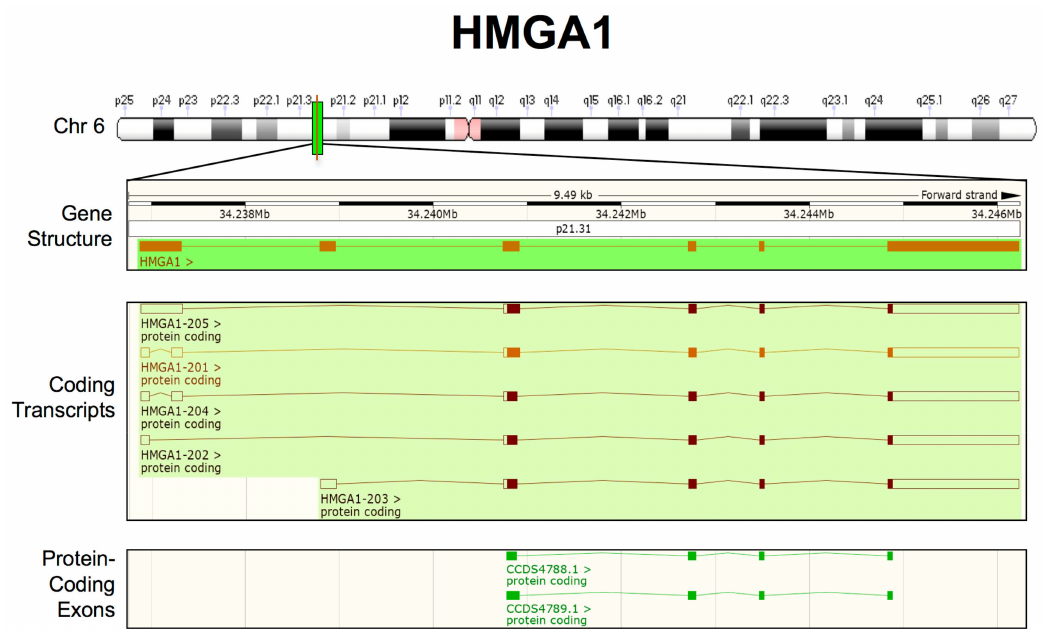
Figure 1. Updated human HMGA1 transcripts structure from Ensembl Genome Browser (GRCh38.p12-GCF_000001405.38). From top to bottom: chromosome 6 (Chr 6) labelled with chromosome bands (white, black and grey), centromeres (pink) and the HMGA1 locus (green); the HMGA1 gene structure, showing the entire length of the region considered, the location on Chr 6 (NC_000006.12):34, 236, 485–34, 246, 445, the chromosome band (p21.31) and HMGA1 exons / introns (orange boxes / lines); and the HMGA1 coding transcripts. The empty boxes indicate UTRs, whereas the filled boxes indicate open reading frames (ORFs). Merged Ensembl / Havana and Ensembl protein-coding data are shown in orange and brown, respectively; HMGA1 protein-coding exons are highlighted in